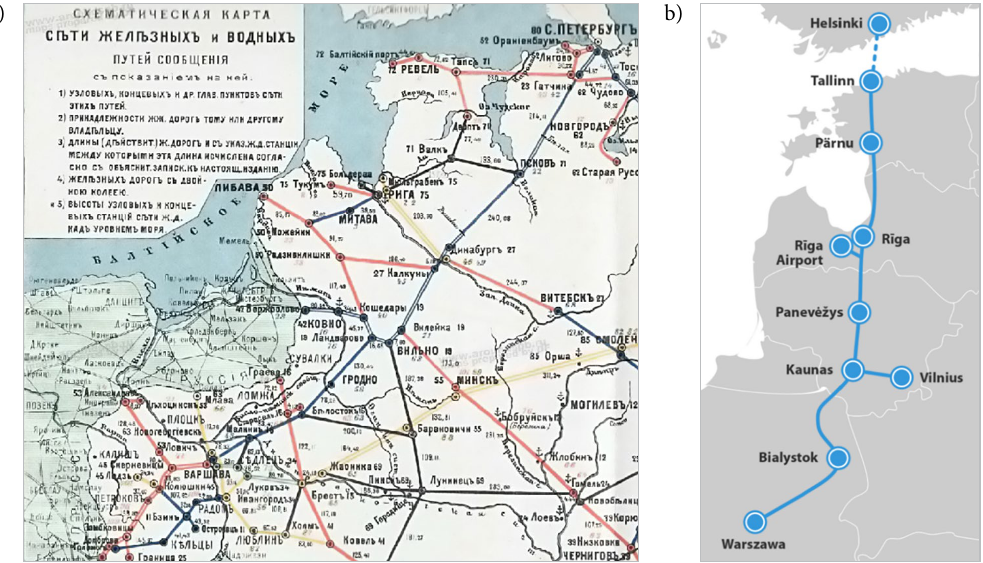
Figure 1. Map of the railway line: a – Saint-Petersburg–Warsaw railway line (in Russian) (ID 2021); b – European railway Rail Baltica line (LR SM 2021a)